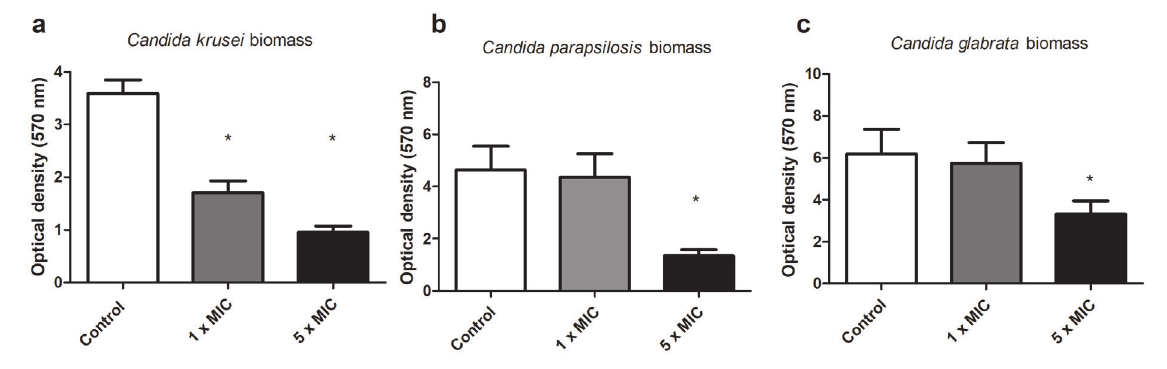
Figure 3. Evaluation of biomass reduction in biofilms of non -albicans Candida species after treatment with verapamil at the MIC and five times the MIC. (a) C. krusei ; (b) C. parapsilosis ; (c) C. glabrata. Asterisks represent statistically significant differences with untreated biofilm (control) as shown by ANOVA (p < 0.05). Error bars represent the SEM (standard error of the mean) of 10 biological replicates.